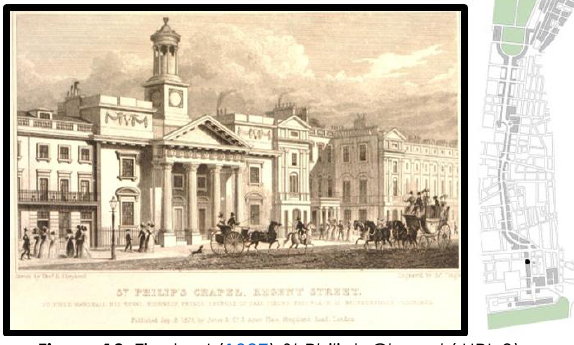
Figure 12: Tingle, J (1827) St Philip's Chapel.( URL